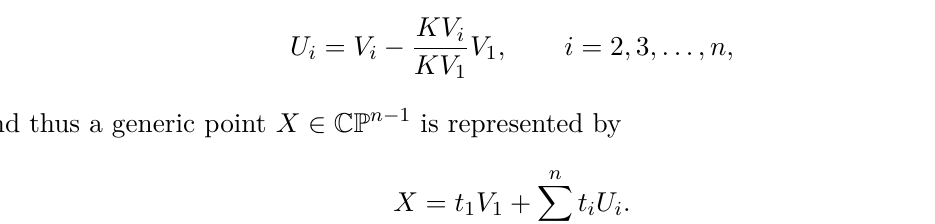
, i.e., V and V , are 1 1 V 2 1 V 3